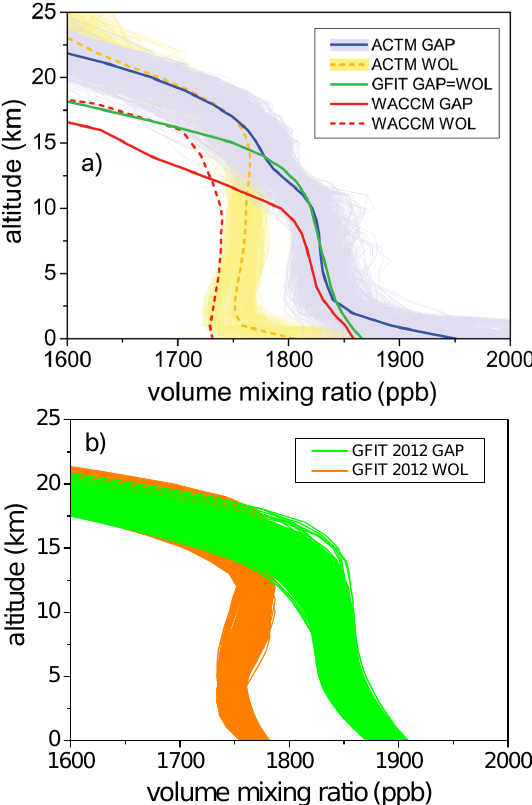
Fig. 1. A priori profiles used in this work. (a) GFIT is the standard a priori profile of the NIR retrievals using GFIT ver. 4.4.10 (release ggg 20091107, one fixed profile for all stations) and WACCM for the MIR retrievals (one per station). The ACTM model profiles (3- hourly model) are suggested as a common prior. (b) A priori pro- files used in the recent GFIT 2012 update, i.e. ver. 4.8.6 (release ggg 2012 July Update). See “Note” for an investigation of the im- pact of this GFIT update.